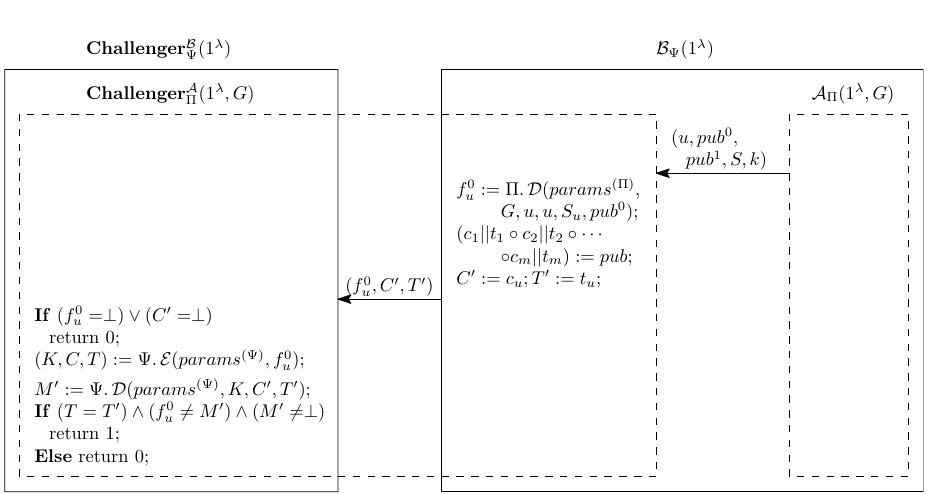
Figure 13: The reduction used in Theorem 7: MLE adversary is constructed using KAS-AE-chain